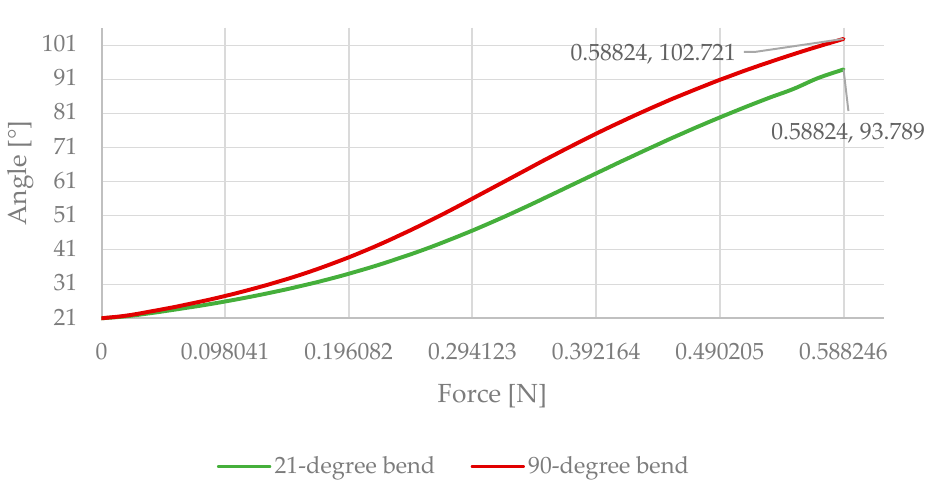
Figure 12. Angle–force diagram for compliant fingers obtained by FEA.